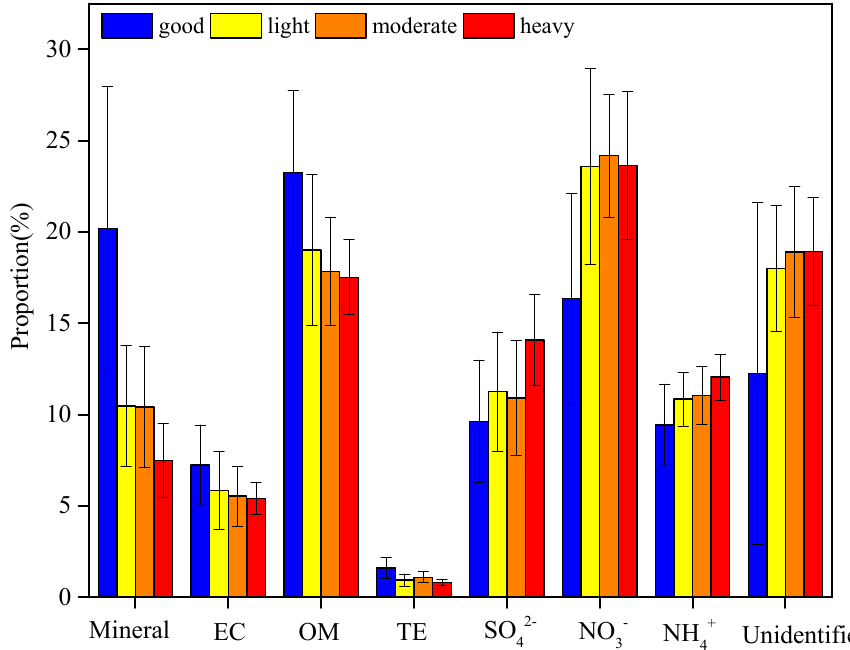
Figure 9. Proportion of major species in PM 2.5 in four pollution days.